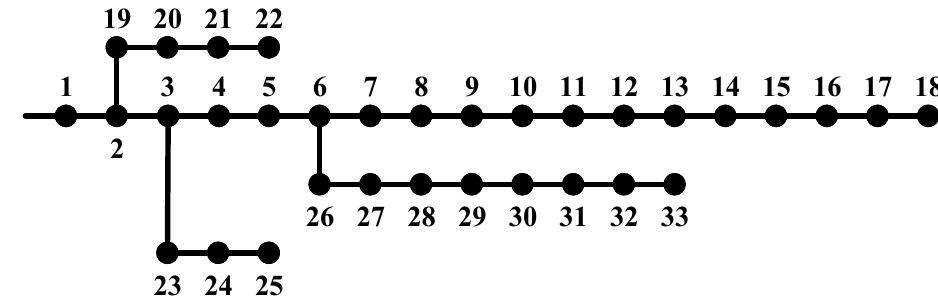
Figure 7. IEEE 33-node power distribution system model.